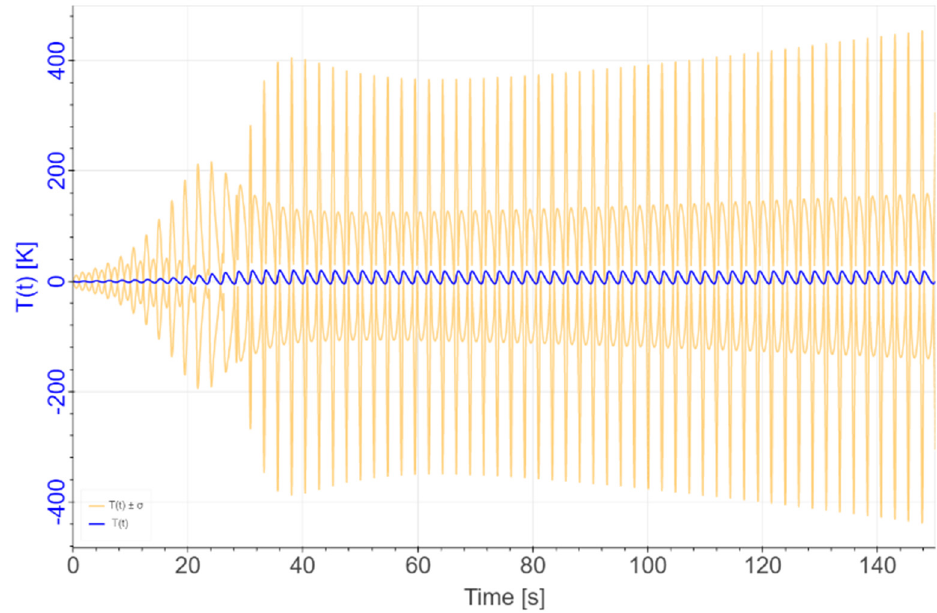
Figure 7. Time-evolution of T ( t ) (blue graph) with uncertainty bands T ( t ) ± σ (yellow graphs), considering uniform 5% relative standard deviations for all parameters and 5% absolute standard deviations for the initial conditions in Region 2.